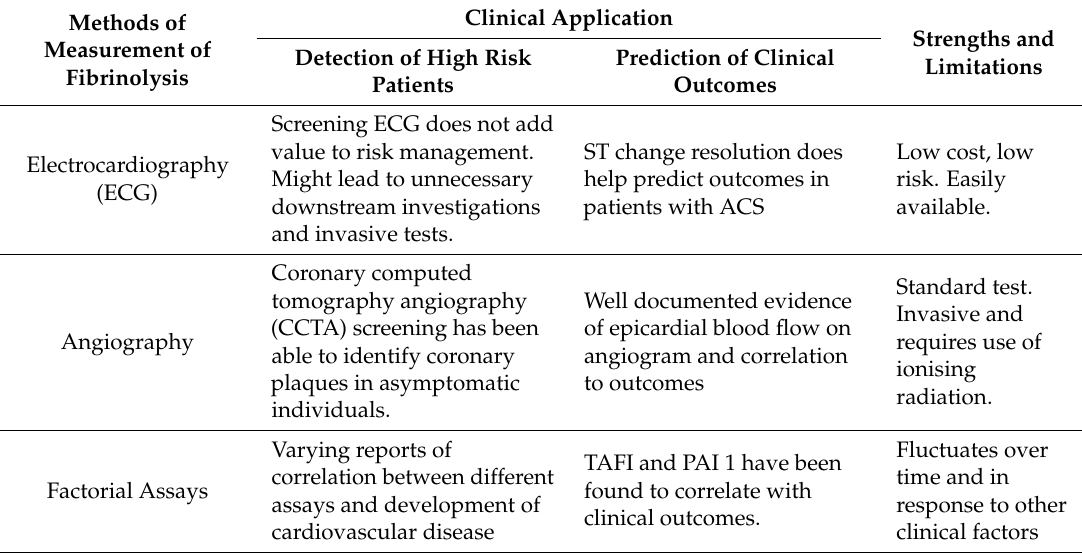
Table 2. Summary of measurements of fibrinolysis, its clinical application, strengths and